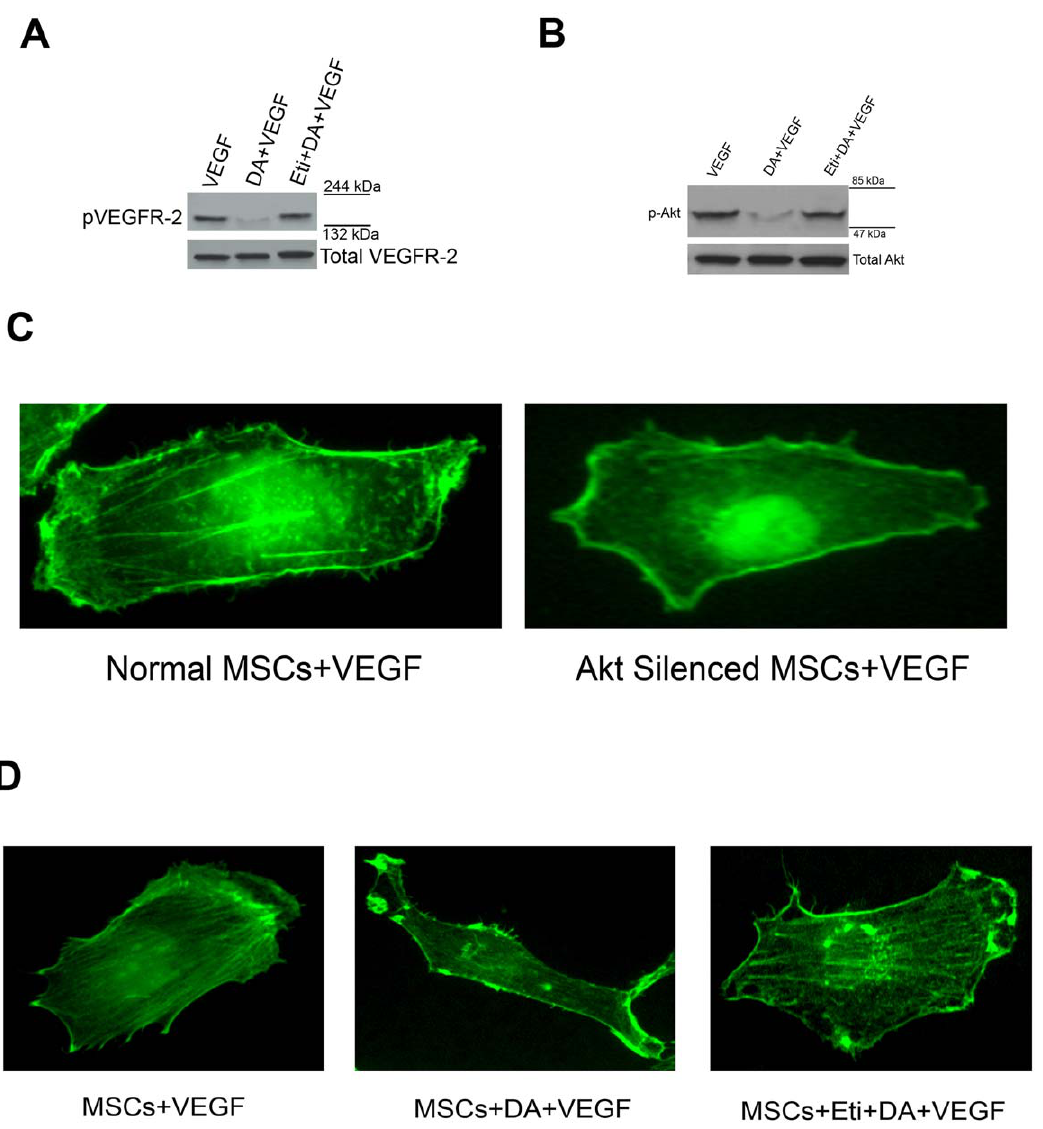
Figure 5. Dopamine (DA) through its D 2 receptors inhibits VEGF induced migration of BM-MSCs by regulating phosphorylation of VEGFR-2 and Akt and actin polymerization. ( A and B ) Effect of DA on VEGF induced phosphorylation of VEGFR-2 and Akt in murine MSCs. Lane 1: Cells stimulated with VEGF (10 ng/ml). Lane 2: Cells pretreated with 1 m M DA before being exposed to VEGF (10 ng/ml). Lane 3: Cells treated with 100 m M eticlopride followed by DA and VEGF. Addition of DA significantly inhibited VEGF induced phosphorylation of both VEGFR-2 receptors and its downstream target Akt when compared with VEGF treated control. Pre-treatment with eticlopride, abrogated DA induced dephosphorylation of both VEGFR-2 and Akt. However, expression of total VEGFR-2 and total Akt remained unchanged. Results are representative of six separate experiments each yielding similar results. ( C ) In actin polymerization assay, VEGF induced MSCs showed significant polymerization of actin cytoskeleton leading to formation of F-actin. However, no such alterations were observed in case of Akt silenced MSCs which showed strikingly lower migratory activity against VEGF than normal MSCs. ( D ) Effect of DA on VEGF induced actin polymerization in MSCs. Treatment with 1 m M DA had significant inhibitory effect on actin polymerization dynamics in MSCs when compared to VEGF treated control. However, pre-treatment with specific DA D 2